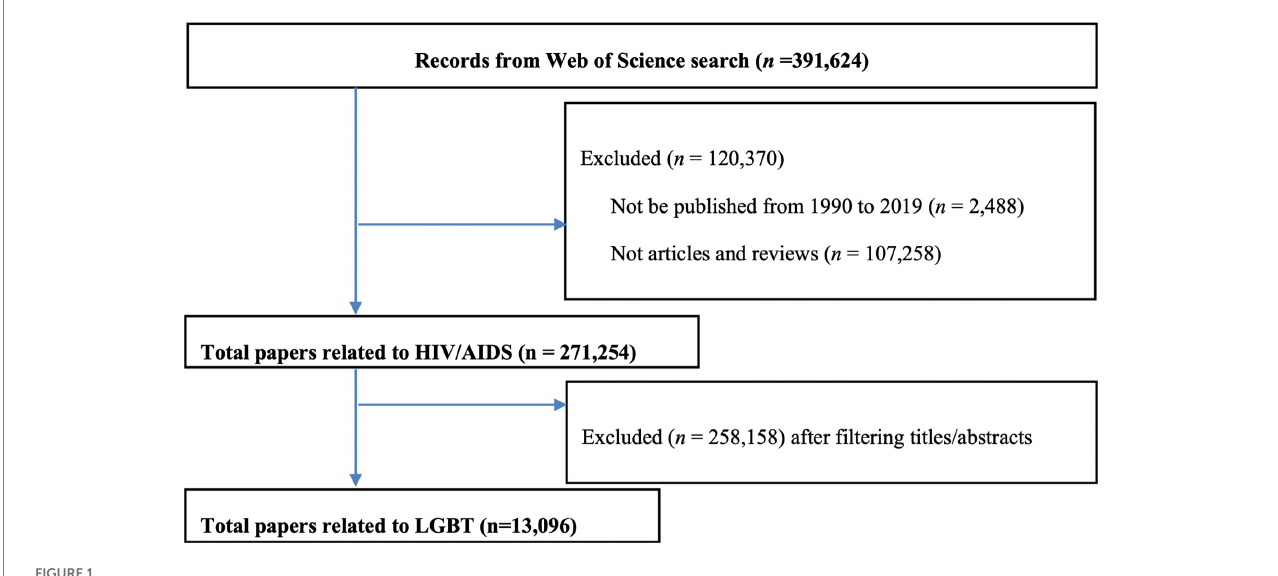
FIGURE 1 Flow chart of the searching